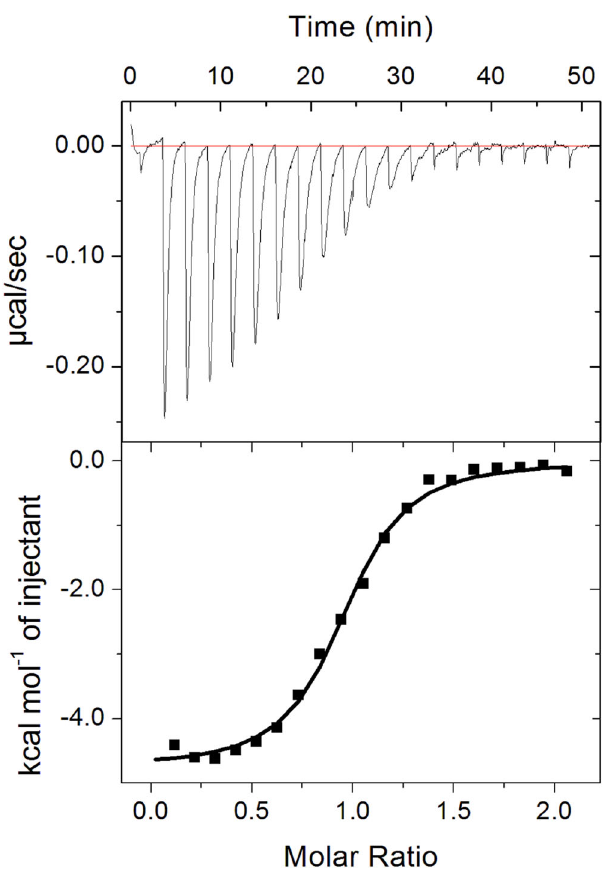
Fig. 6 Calorimetric titration of ReAV with Zn 2 + cations. The top panel shows the raw data obtained from 19 consecutive 2 μ L injections of 1 mM ZnCl 2 solution into the sample cell (200 μ L) containing 100 μ M of the protein. Heat peak areas were plotted against the Zn:protein molar ratio to create the binding isotherm of the bottom panel. The best fi t of a model of one set of binding sites is represented by the black line. Source data are provided as a Source Data fi le.